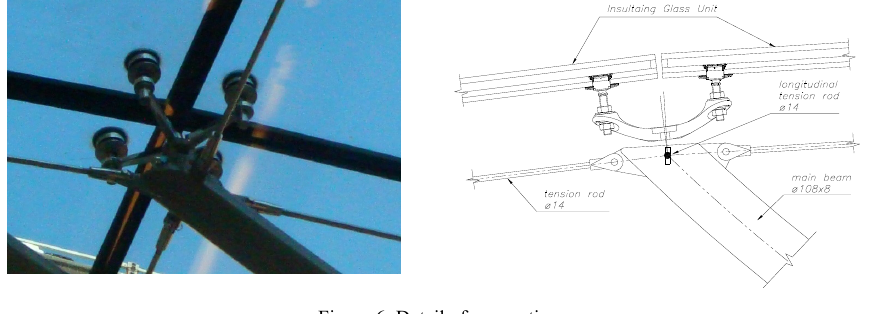
Figure 6: Detail of